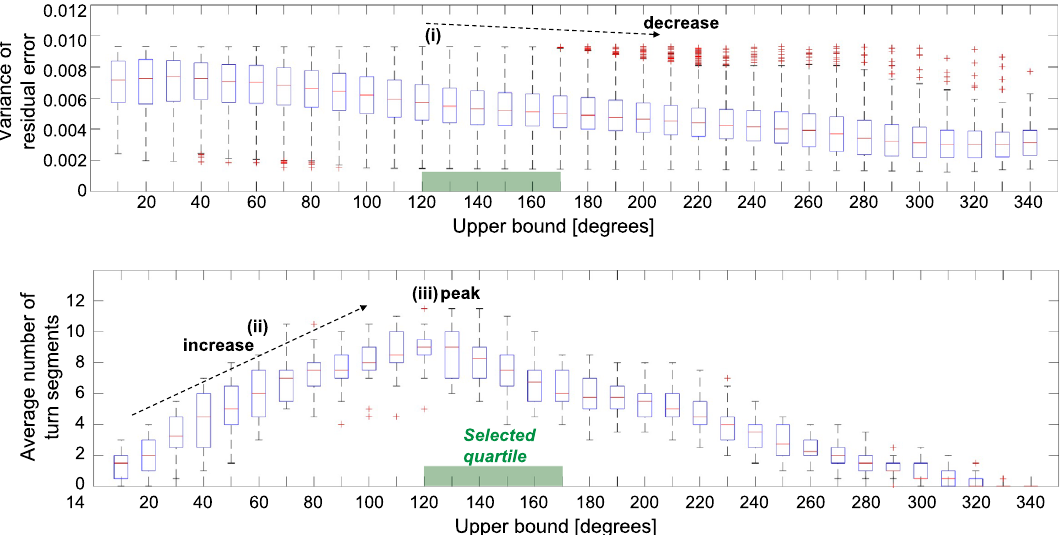
Figure 4. Variance of residual error and average number of turn segments across the iterated upper bound segmentation parameters, with decreasing variance of residual error (i) and increasing average number of turn segments (ii) across upper bound values. The peak in average number of turn segments is at 120° upper bound (iii). Please find the definition of upper bound in the Methods